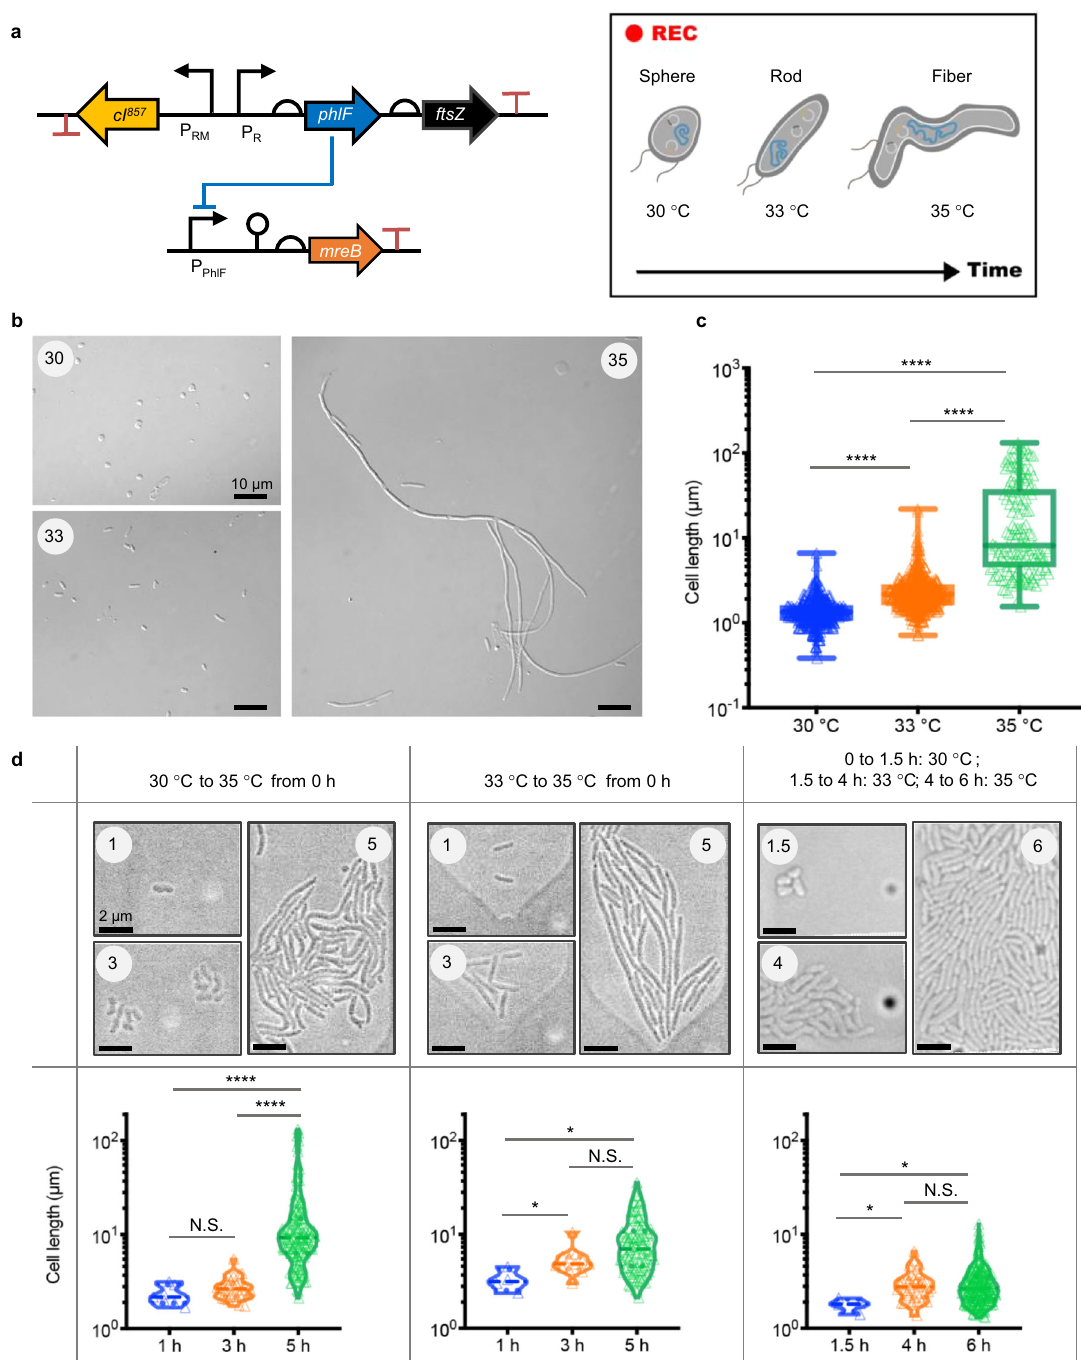
Fig. 4 Thermal responsive cell morphologies changes from rod to spheres or to fi bers. a Construct for controlling cell morphology. The expression of two morphology related genes, mreB and ftsZ , enabling formations of sphere- and fi ber-shape cells, respectively, were controlled by the T-switch system. b Confocal imaging of cells harboring 145 + 221 constructs cultured at constant temperature, 30 °C, 33 °C and 35 °C, scale bar = 10 μ m. c Quantitative measurements of cell lengths by imageJ from at least 9 images from part b containing over 150 captured cells manually. d Bifunctional dynamic control of cell morphology among shapes of spheres ( mreB overexpressing), rods (normal cell type) and fi bers ( ftsZ overexpressing) were on-line recorded in a micro fl uidics with a scale bar of 2 μ m. Sample sizes of collected cells of each time point varied signi fi cantly depending on the growth phase, 3 – 10 cells at 1 h, 10 – 40 cells at 3 h, and 100 – 240 cells at 5 h. All data in c and d are displayed in Box-plot: a value of median, quantiles, mini- and maxi-mum. One-way ANOVA with Tukey-Kramer test was used in c and d . p value: N.S. not signi fi cant; * p < 0.0332; ** p < 0.0021; *** p < 0.0002; and **** p <